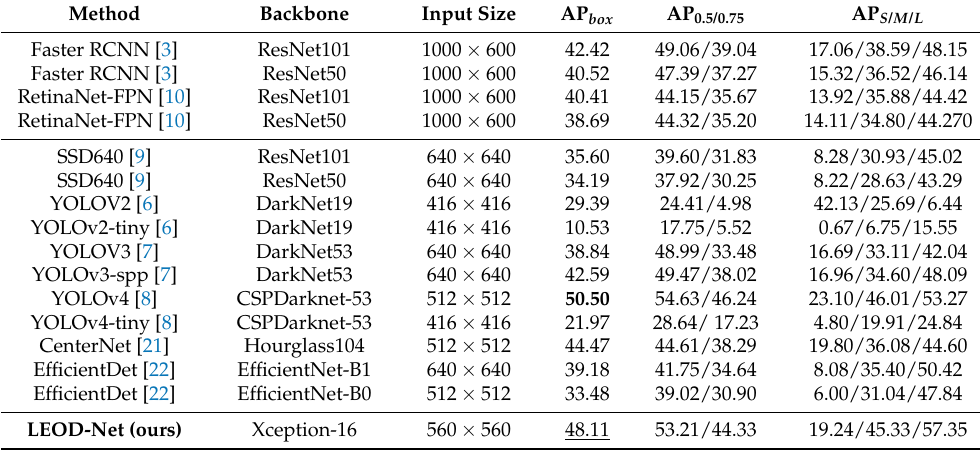
Table 5. Comparison between the proposed method (LEOD-NET) and SOTA methods on COCO val2017 (COCO minival) while training the model on COCO train2017 dataset. The best value of AP box is shown in bold. The second best value is shown with